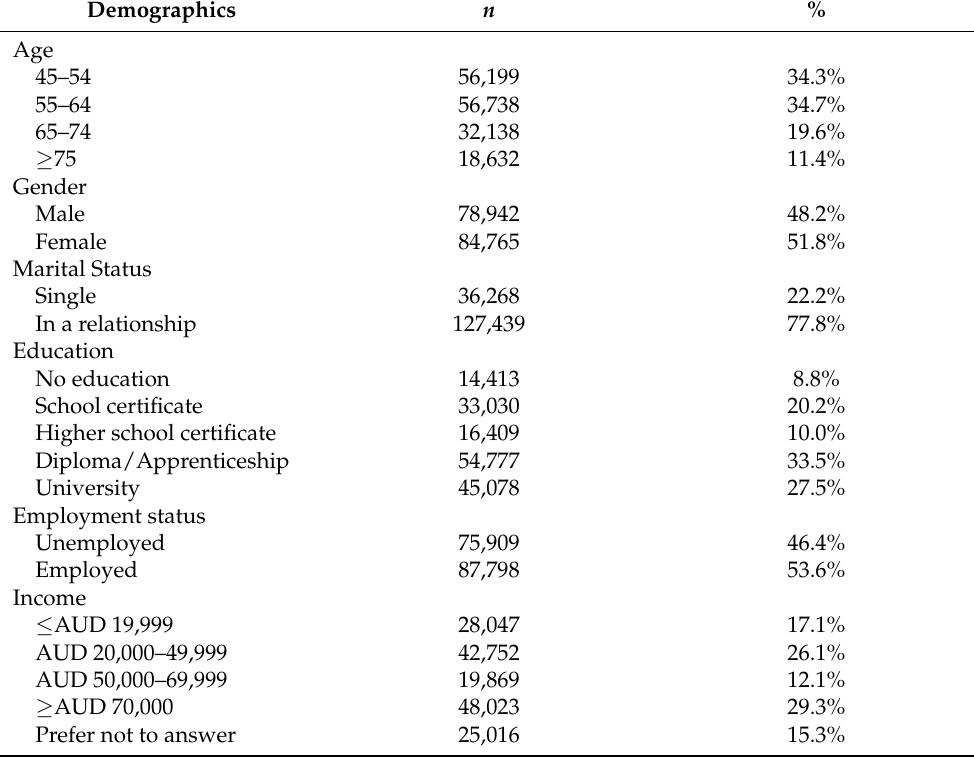
Table 1. Demographic characteristics of the sample at